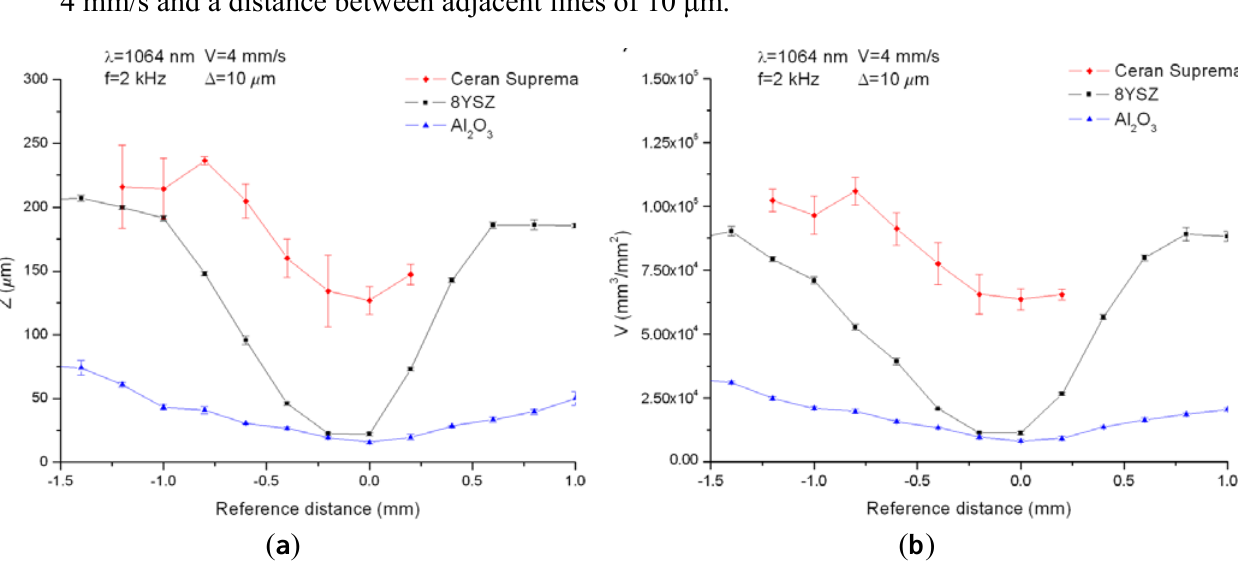
O and glass-ceramic 2 3